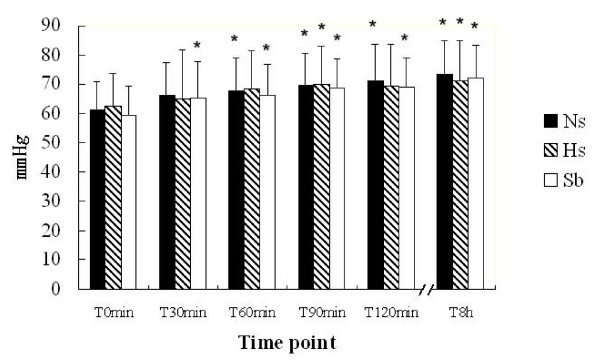
Effects of fluid resuscitation on MAP in the three groups. MAP in all patients was registered by professional statisticians in the hospitals. There were no differences in MAP among the three groups at all the six time points. Comparing MAP in the same group, MAP at T60, T90, T120 and T8h was significantly higher than that at T0 in the Ns group; the parameter at T90, T120 and T8h was higher than at T0 in the Hs group; and MAP at T30, T60, T90, T120 and T8h were higher than that at T0 in the Sb group (*p < 0.05). MAP increased earlier in the Sb group than in the Ns and Hs groups.